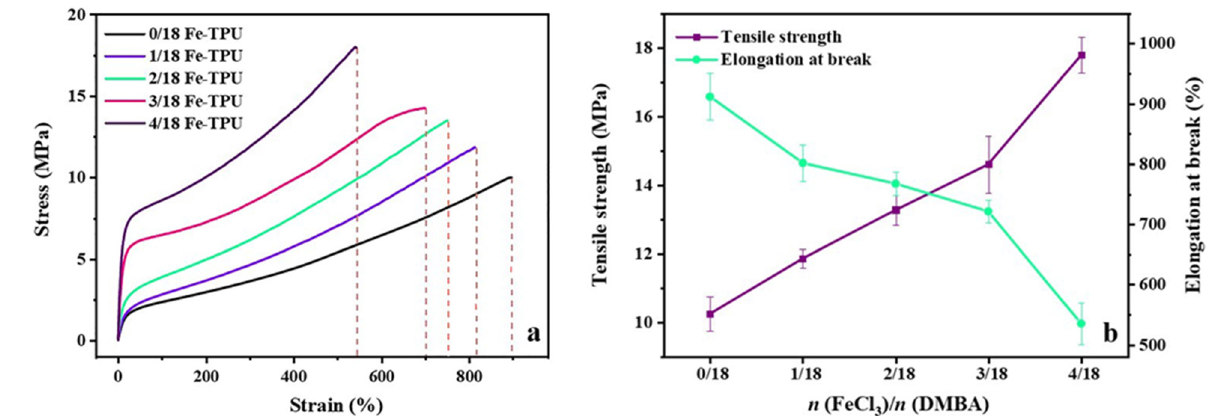
Figure 6. ( a ) Tensile stress–strain curves, ( b ) mechanical performances of TPU reinforced with FeCl 3 .